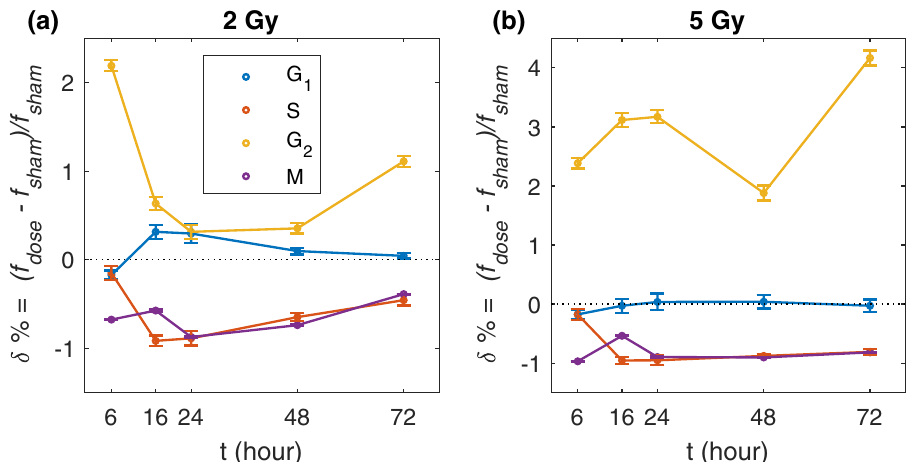
Figure 4. Relative differences between the irradiated and the sham condition. 2 Gy versus sham (a) , and 5 Gy versus sham (b) , relative differences in the percentages of cells in each phase as a function of time (lines are a guide for the eye). Numerical data are reported in Table